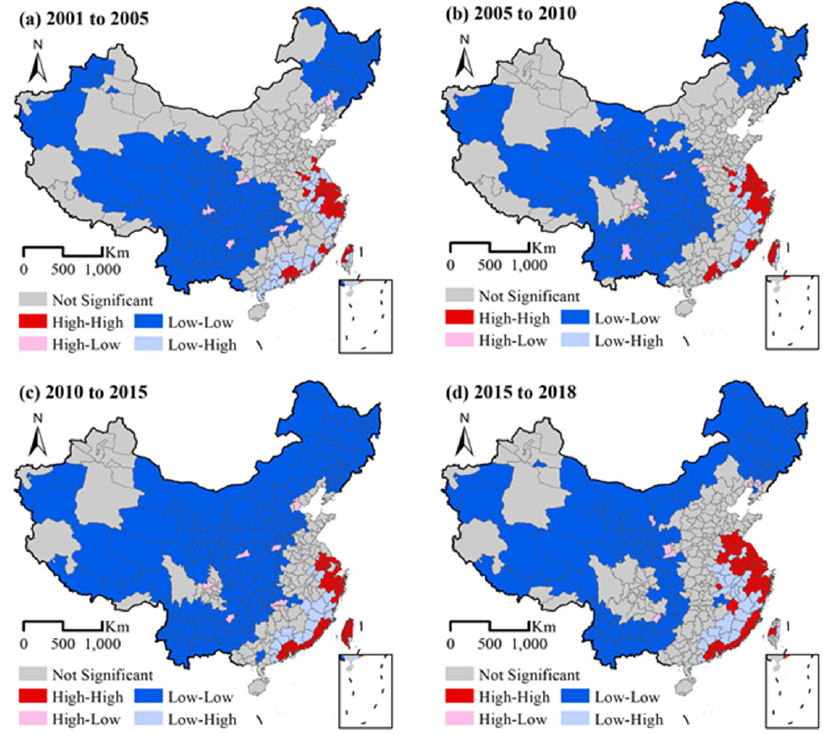
Figure 9. Moran of UCL-related loss distribution.